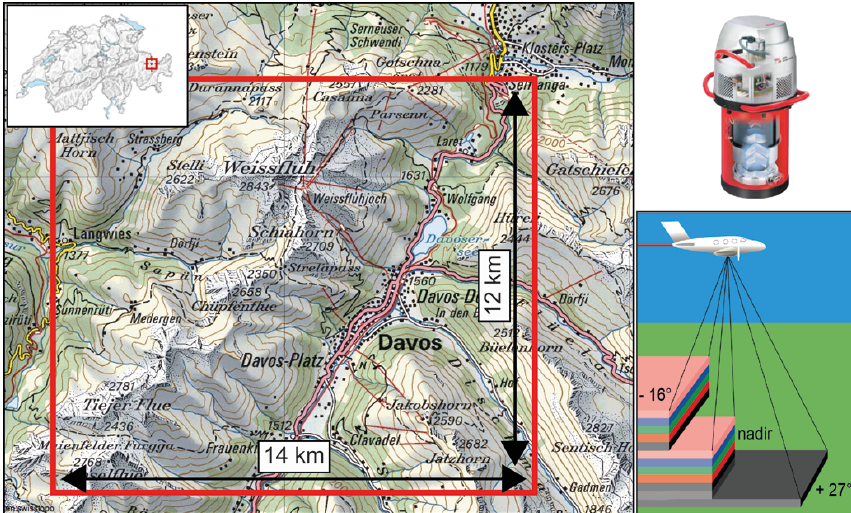
Fig. 1. Extent of the test site Davos, Switzerland (left), and images of the ADS80 digital optoelectronic scanner and its acquisition mode (right, www.leica-geosystems.com). Pixelmap © 2012 swisstopo